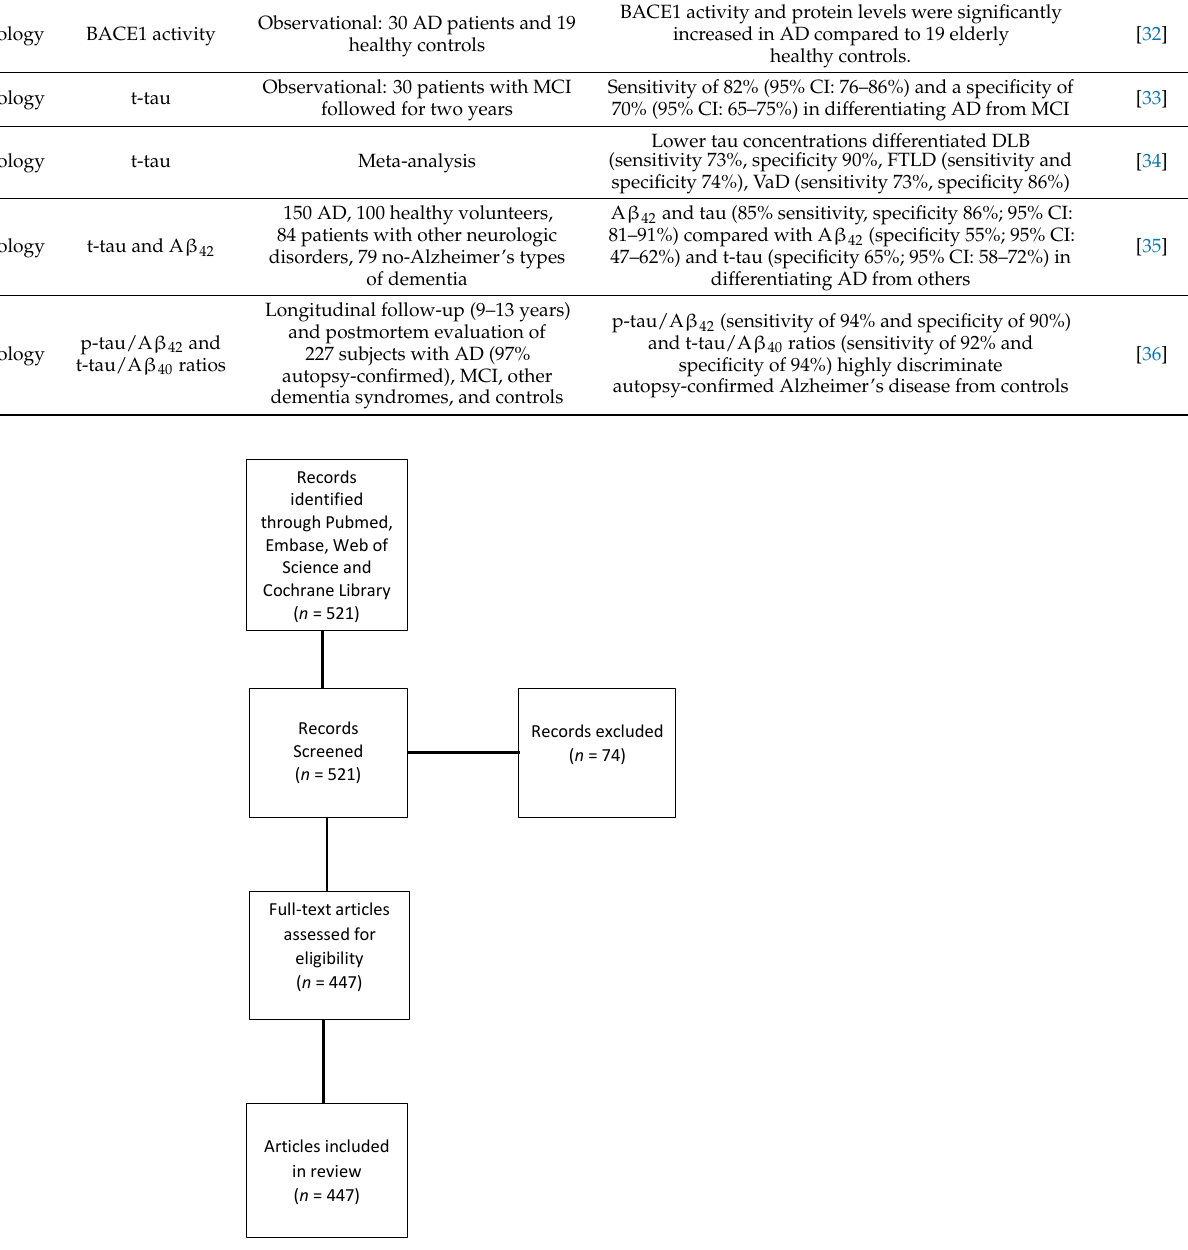
Figure 1. Flow chart of literature search and study selection. Table 1. Pathological mechanisms (Aβ and tau pathology) and associated biomarkers of Alzheimer’s disease and the find- ings of related studies.